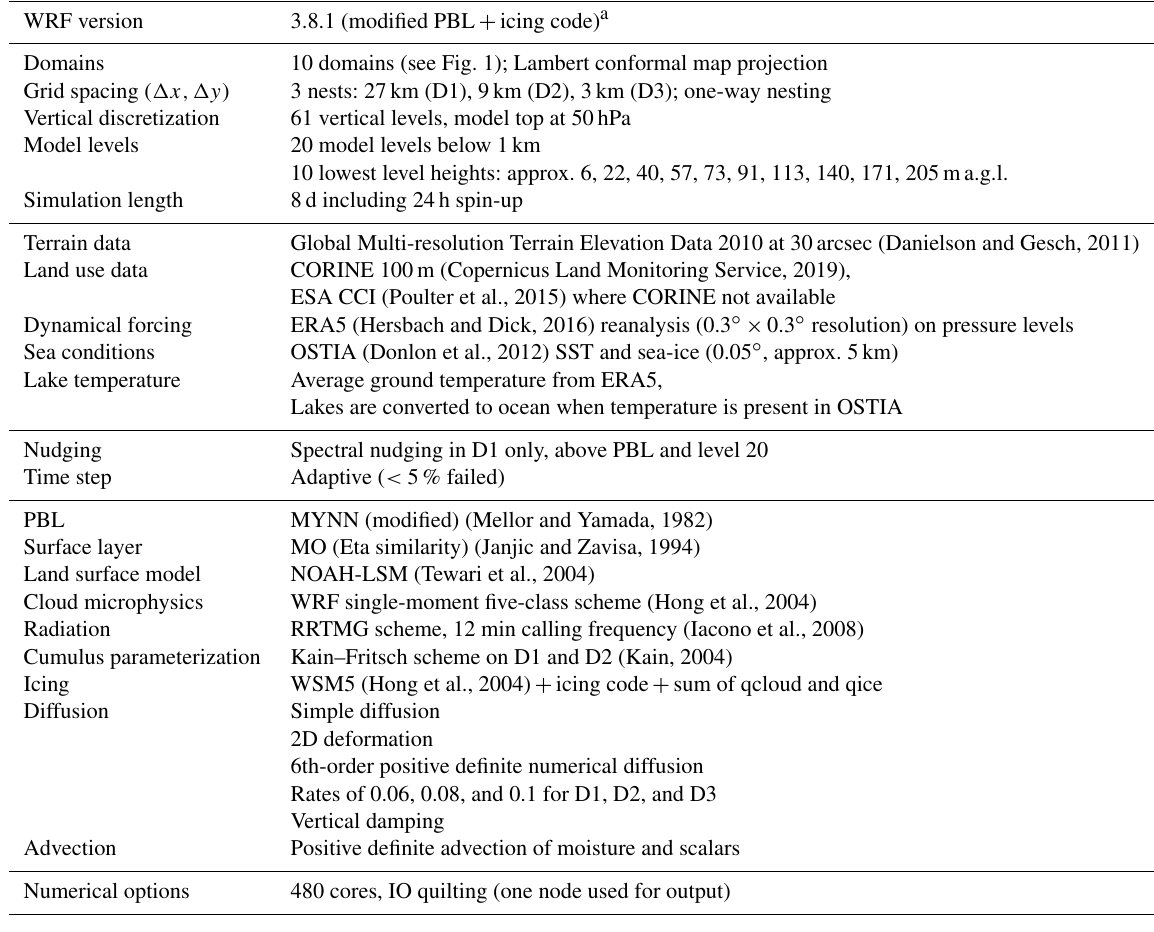
Table 1. Setup configuration used in the NEWA production